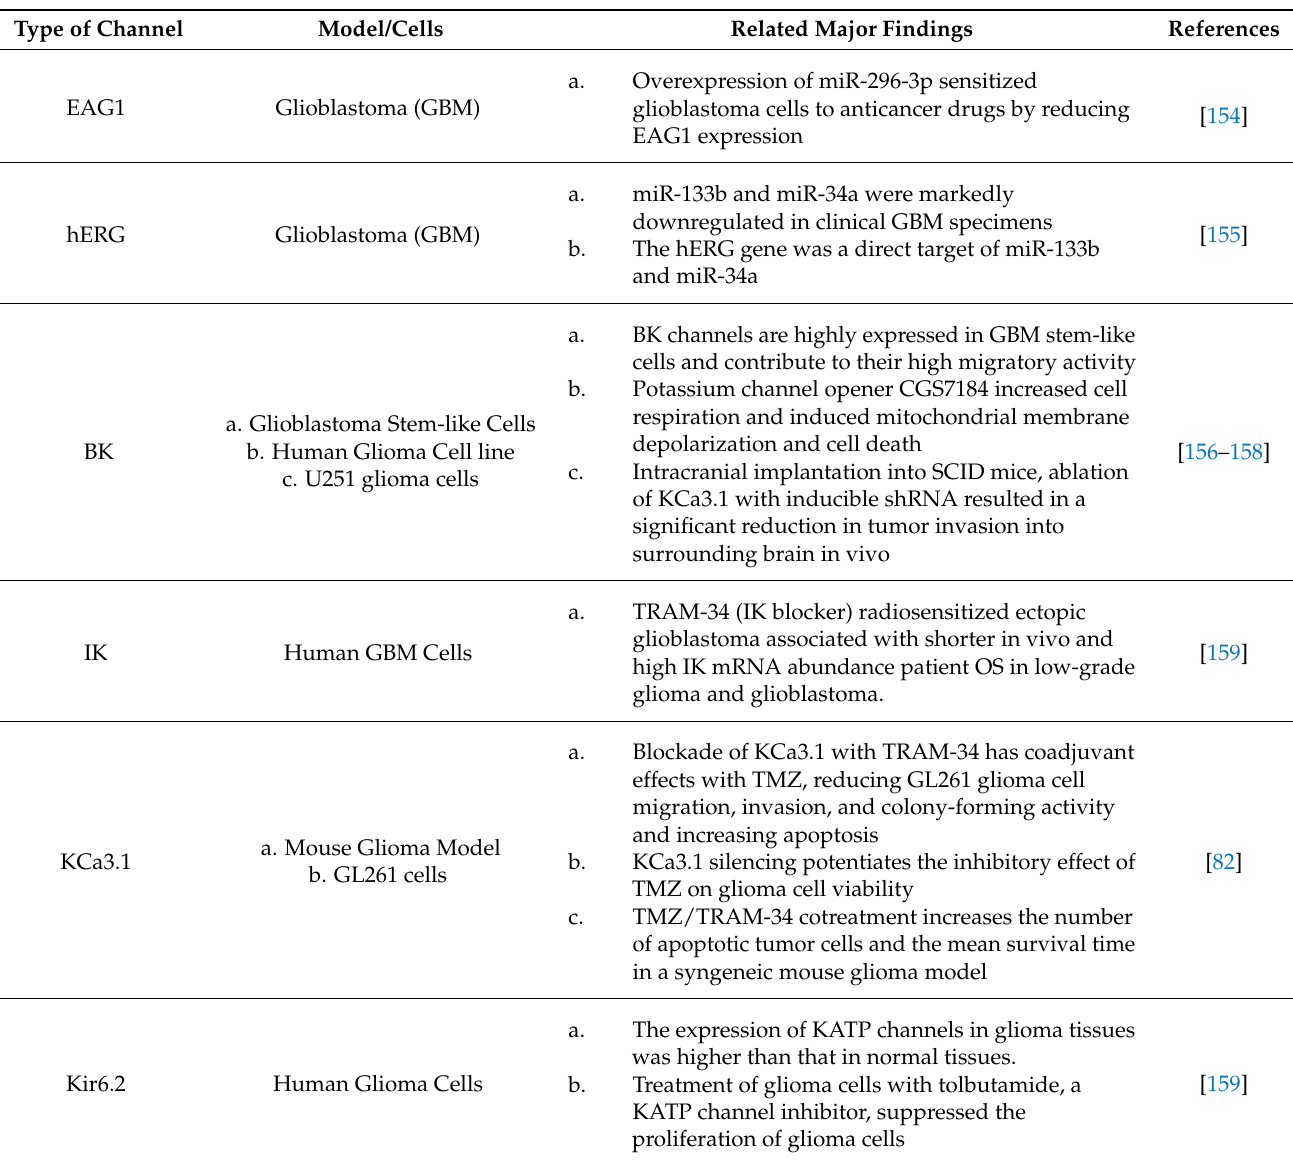
Table 1. Type of potassium channels manipulated in the associated glioma cell line/model with a summary of major related